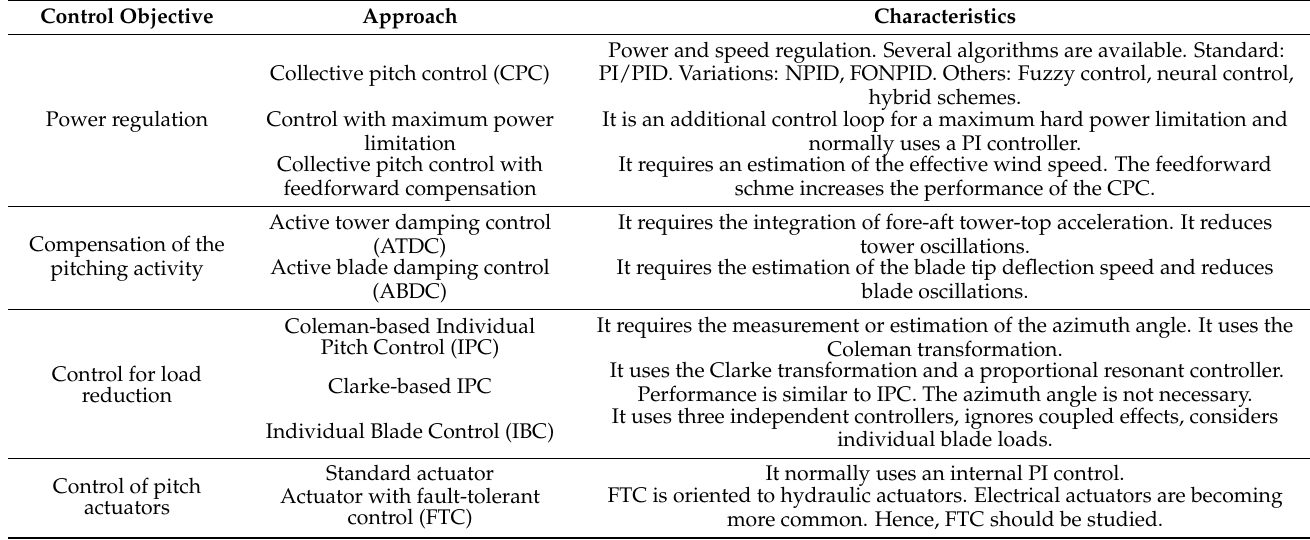
Table 1. Summary of methods used for the pitch control of large wind